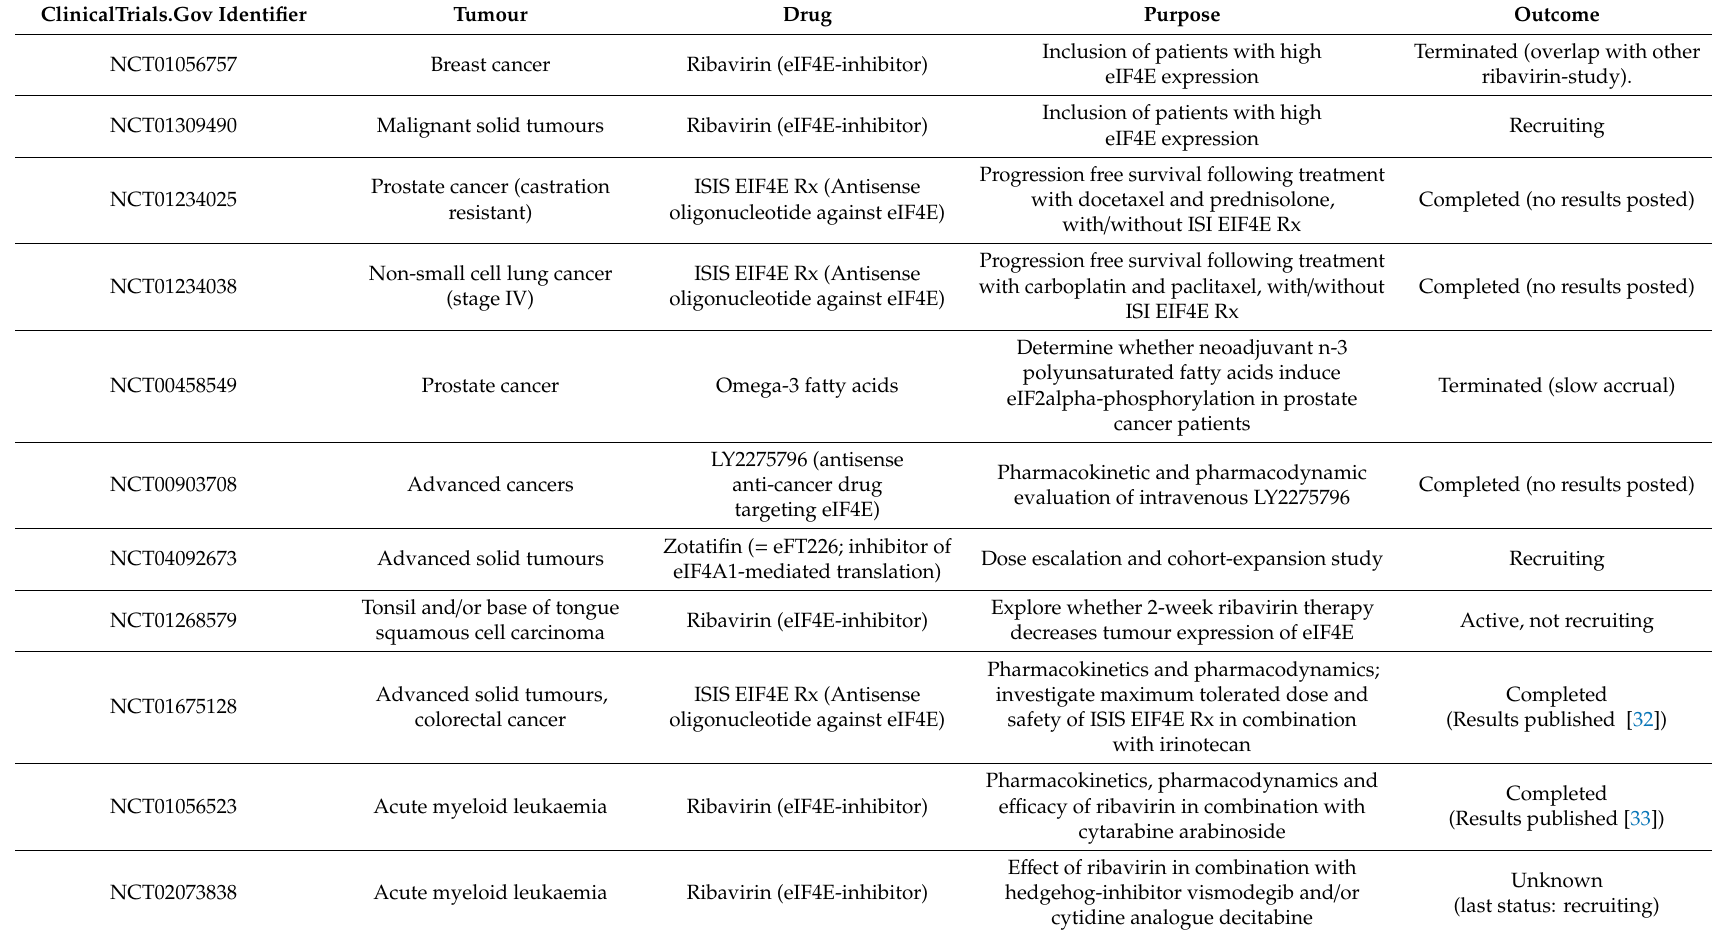
Table 1. Clinical trials registered on ClinicalTrials.gov investigating the role of eukaryotic translation initiation factors (eIFs) in cancer *. ClinicalTrials.Gov